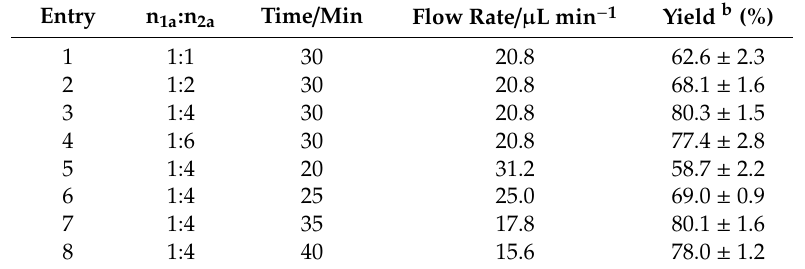
Table 3. E ff ects of substrate ratio and residence time on enzymatic synthesis of β -amino acid esters. a Table 3. Effects of substrate ratio and residence time on enzymatic synthesis of β-amino acid esters. a